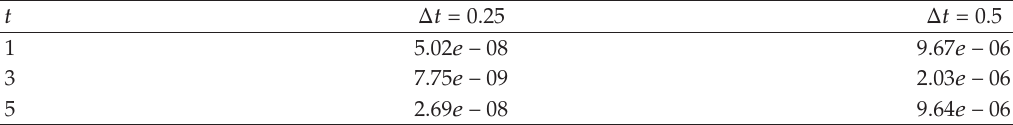
Table 7: Relative errors of Problem 3 with N (cid:6) M (cid:6) 11 , α (cid:6) 5 , β (cid:6)